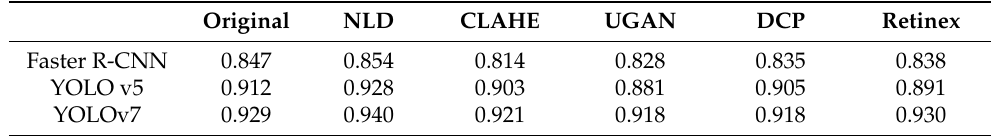
Table 4. Performance evaluation (AP 50 ) of YOLOv7, YOLO v5 and faster